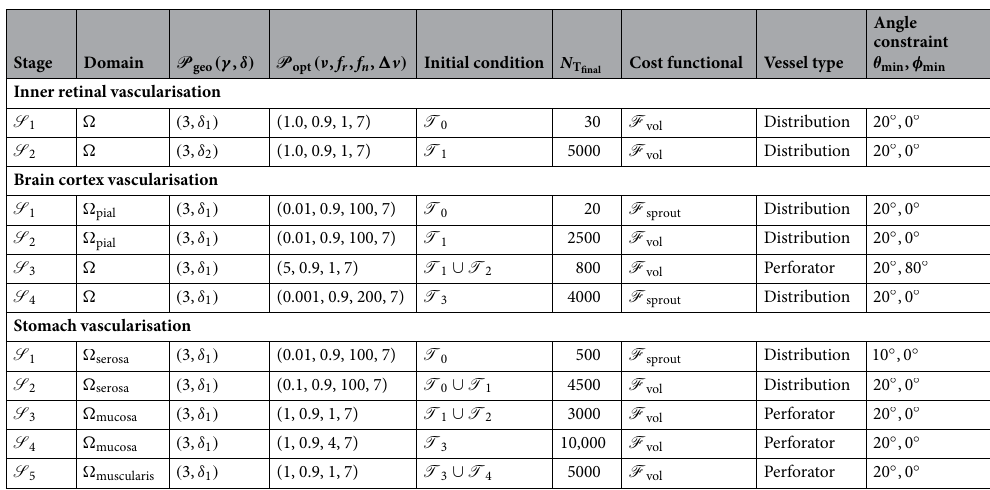
Table 1. DCCO parameter setup for each of the vascularisation processes. The F sprout was instantiated with parameters c v = 1.0 × 10 4 , c p = 0.5, c d = 1.0 for the brain cortex and c v = 1.0 × 10 2 , c p = 0.5, c d = 2.0 for the stomach case. Symmetry ratio constraint parameters δ 1 and δ 2 are presented in (19); and θ max and φ max are the supplementary angles of θ min and φ min , respectively.